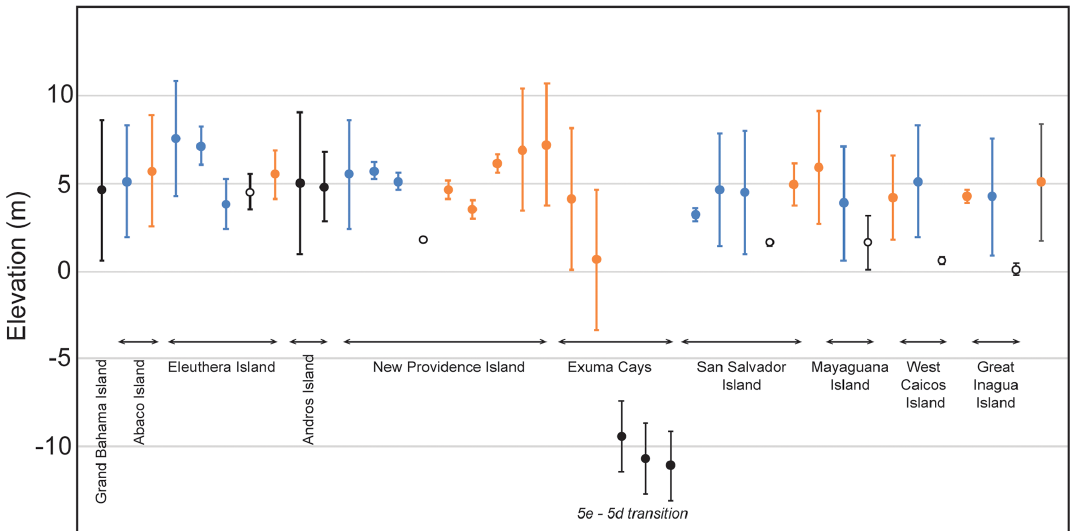
Figure 2. Relative sea-level position during MIS 5e across the Bahamas and Turks and Caicos. Data are grouped by island and ordered roughly north to south from left to right across the diagram. Symbols are as follows: black circles: MIS 5e; blue circles: early MIS 5e; orange circles: late MIS 5e; open circles: erosional or subaerial exposure surface. Uncertainties represented by error bars include the combined uncertainty of the elevation measurement and indicative range of the sea-level indicator by adding the uncertainties in